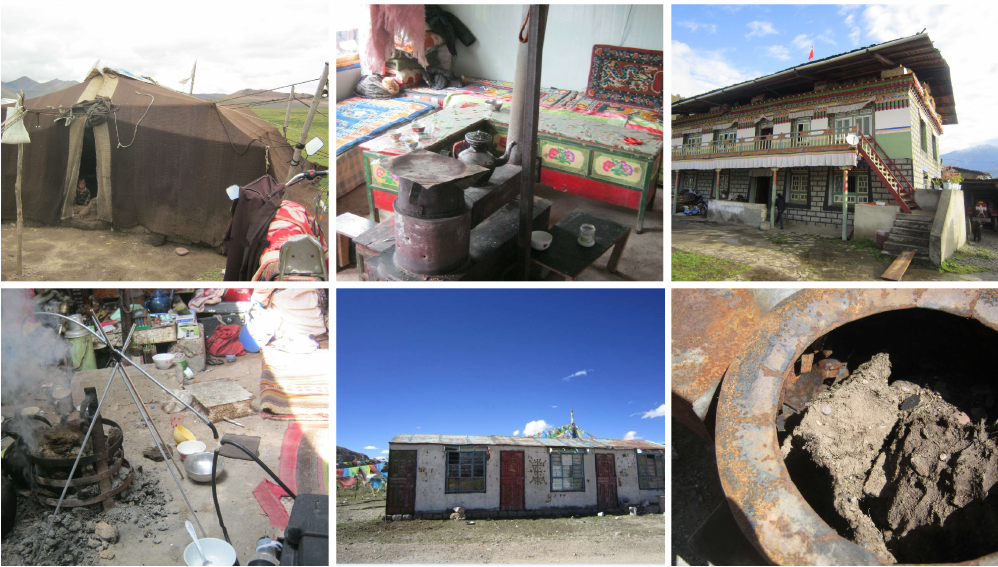
Figure 2. The household, stove, and fuel in Tibet ( top left : Tibetan tent in Nam Co; top middle : chimney stove; top right : household in Linzhi; bottom left : open fire stove in Nam Co; bottom middle : household in Nam Co; bottom right : yak